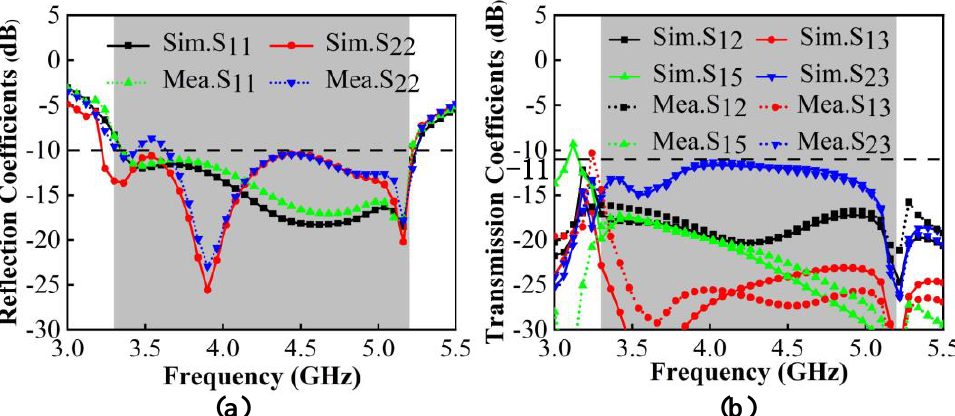
Figure 13. ( a ) Simulated and measured reflection coefficients. ( b ) Simulated and measured transmission coefficients.